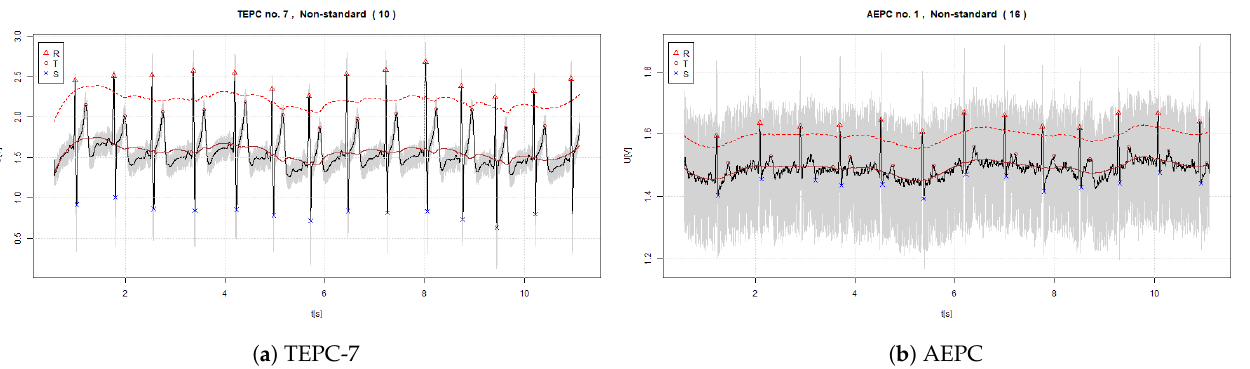
Figure 7. Measured signals of ECG acquired using the TEPC7 and AEPC (where the continuous red line denotes the baseline and dashed red line 60% threshold